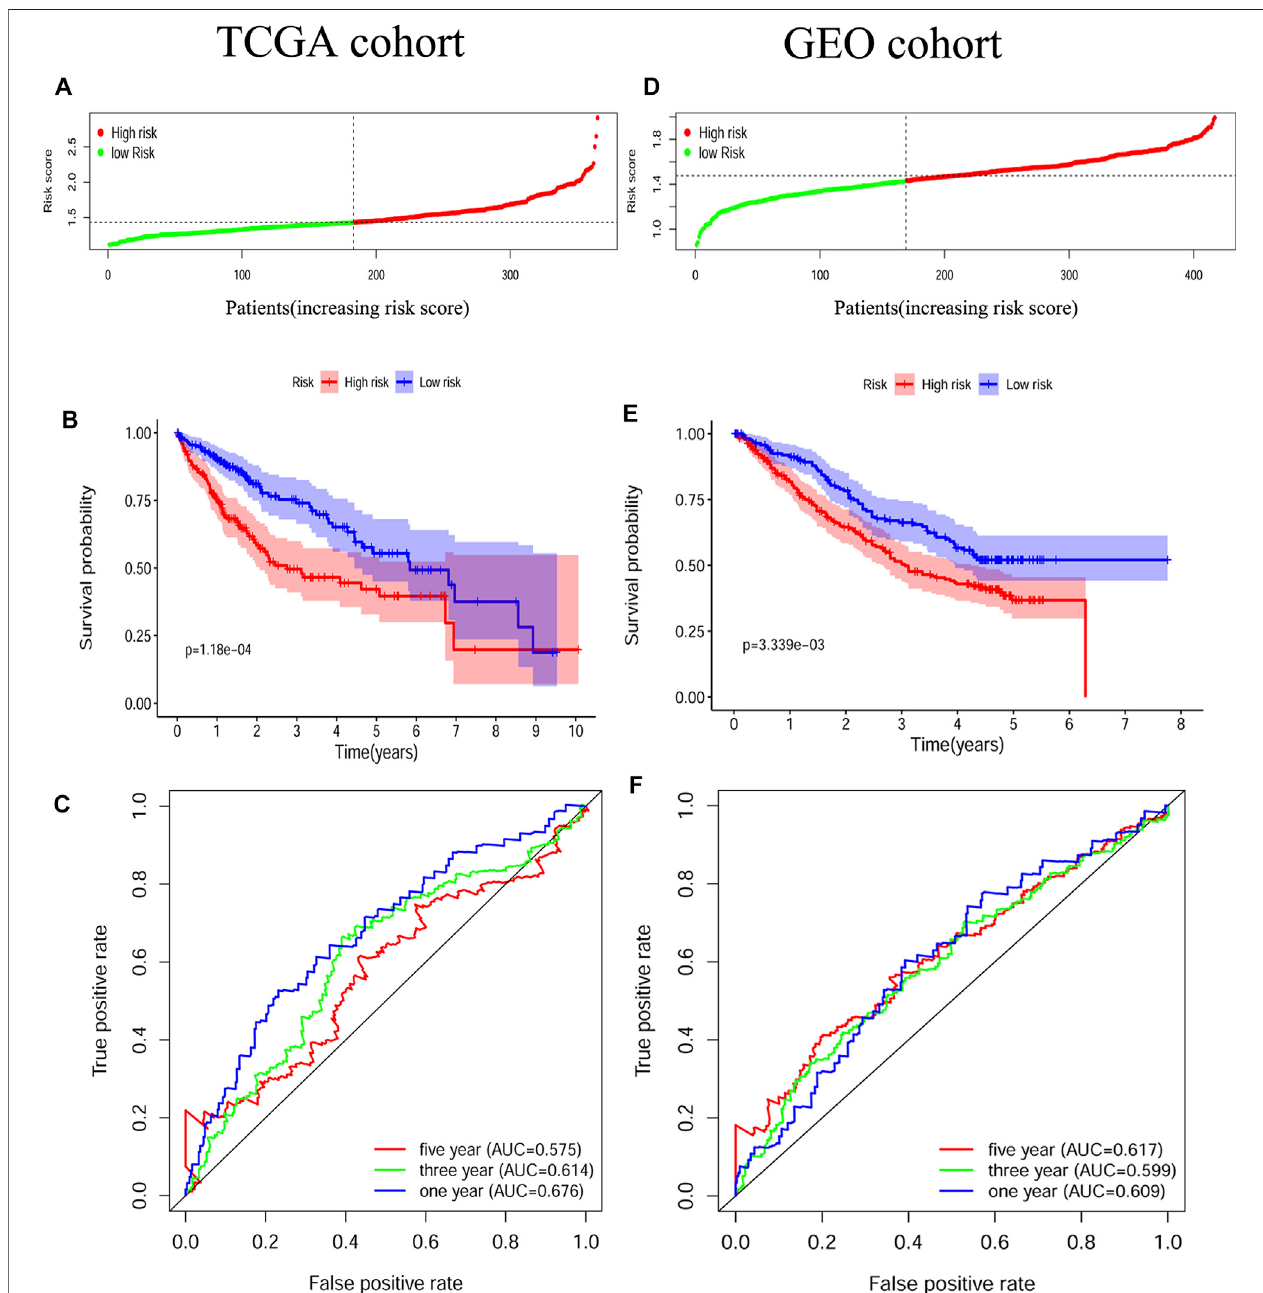
FIGURE 4 | Construction and validation of the pyroptosis-related gene signature (A) Patients divided by the median risk score in the TCGA cohort (B) Survival analysis between the high-risk and low-risk groups in the TCGA cohort (C) ROC curves indicated the accuracy of the prognostic model in the TCGA cohort (D) Patients divided by the median risk score in the GEO cohort (E) Survival analysis between the high-risk and low-risk groups in the GEO cohort (F) ROC curves indicated the accuracy of the prognostic model in the GEO cohort.